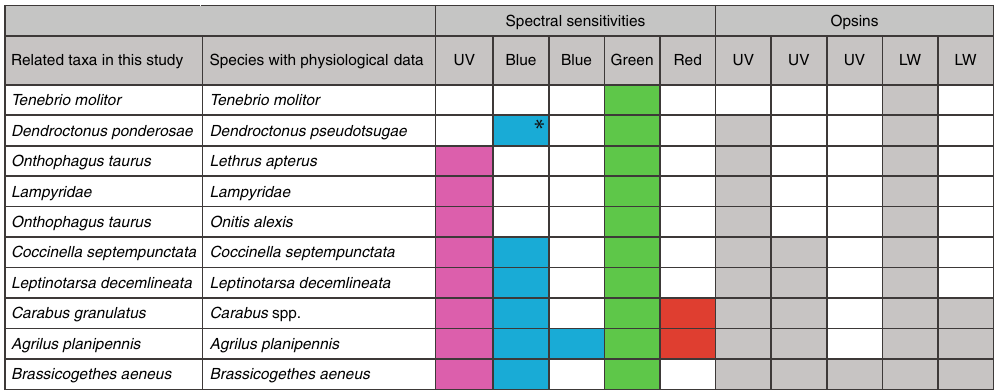
Figure 4. Comparison of spectral sensitivities and opsins found in this study for matching or similar species. * Measurements from Dendroctonus pseudotsugae were made in the absence of UV stimuli. The “blue-sensitive” photoreceptors discovered in this species most likely peak in the